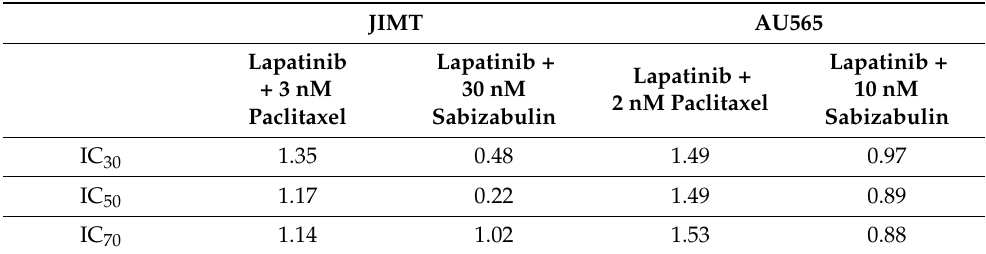
Table 2. Combinatorial indices (CI) as determined by isobole testing at the IC 30 , IC 50 and IC 70 values for paclitaxel or sabizabulin when paired with lapatinib in JIMT and AU565 HER2+ cell lines. Results are representative of three biological replicate isobole assays. Values < 1.0 indicate synergistic drug action, while values of approximating 1.0 are indicative of an additive effect, whereas values > 1.0 suggest